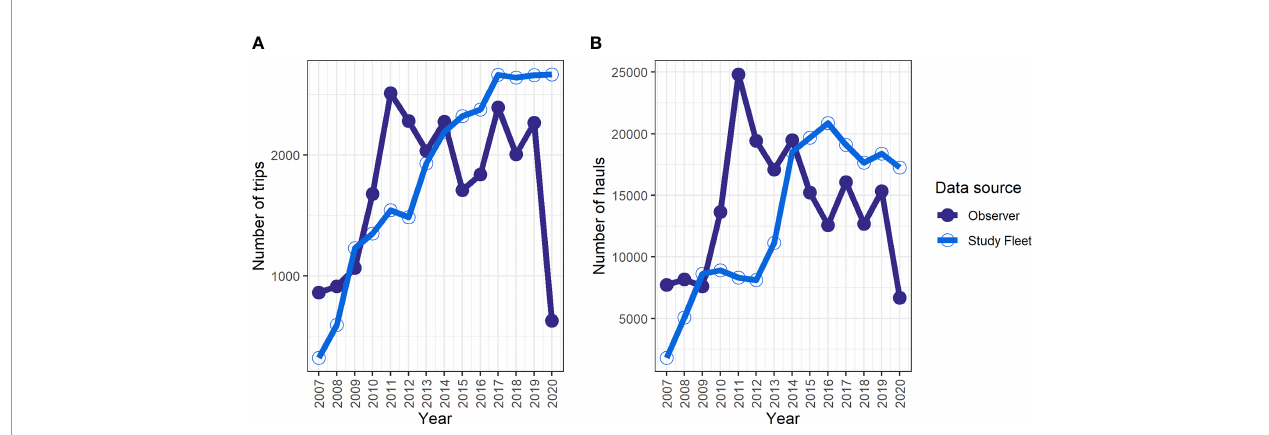
FIGURE 4 | Trends in annual trips (A) and hauls (B) for the Study Fleet program are shown in blue (open circles). For comparison, the annual number of trips and hauls from trawl vessels is shown in purple (closed circles) from another large monitoring program in the region, the fi shery observer programs. The goals and sampling schemes of these programs are quite different, but together they represent a large amount of fi shery dependent data from the region. Of note is the dip in total trips in the observer program in 2020, a result of a pause in operations for the COVID-19